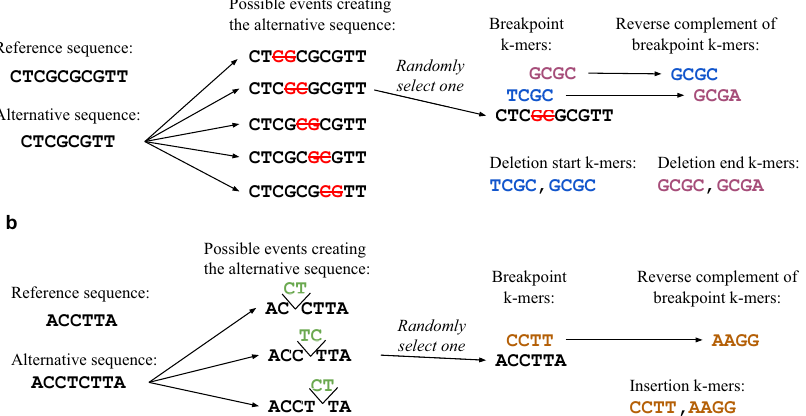
theobserved k-merand itsreverse complement. a Deletionexample.Fordeletions where we consider both the k-mer around the start breakpoint and the end breakpoint. The reverse complement of a deletion start k-mer is a deletion end k-mer and vice versa. b Insertion